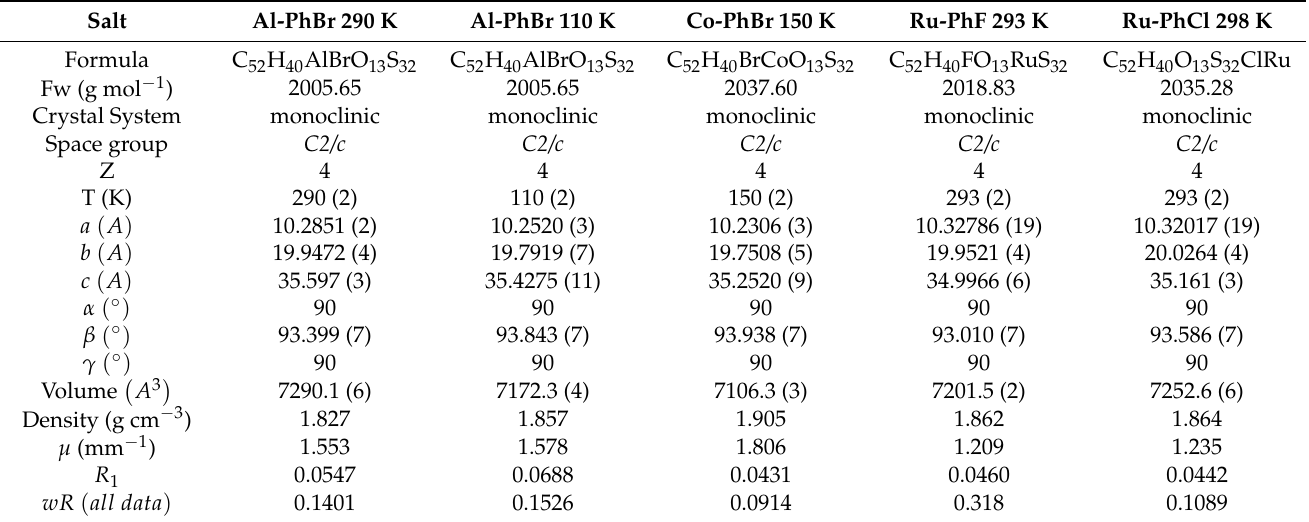
Table 1. Crystal data for β ”-(BEDT-TTF) 4 (H 3 O) M (C 2 O 4 ) 3 · G salts.